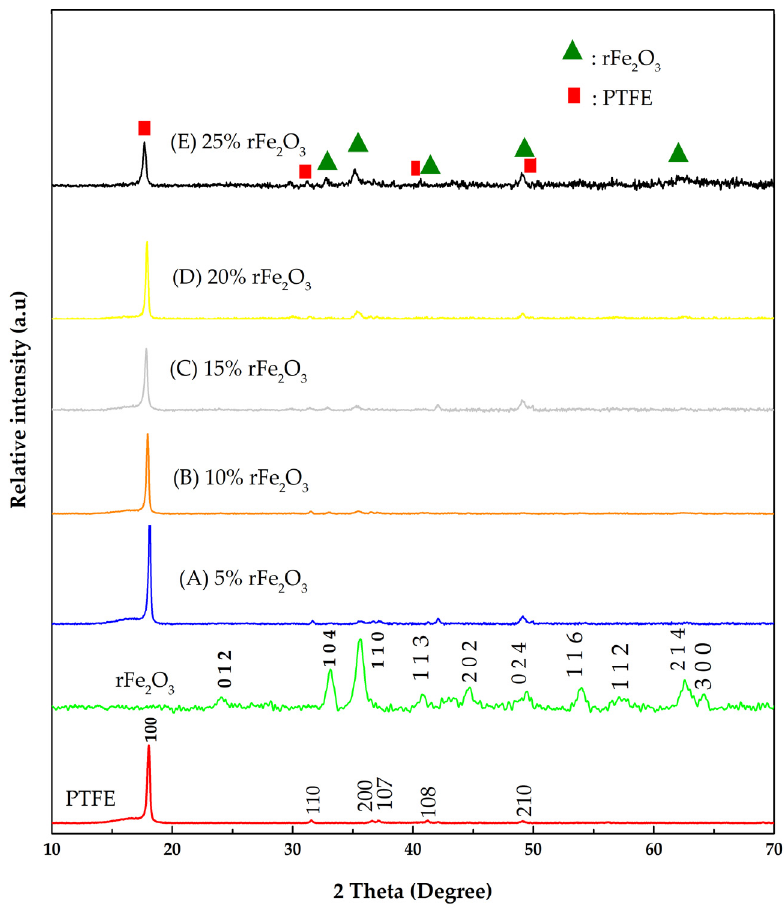
Figure 5. XRD diffractograms of the rFe 2 O 3 nanoparticles, PTFE, and rFe 2 O 3 –PTFE nanocomposites.